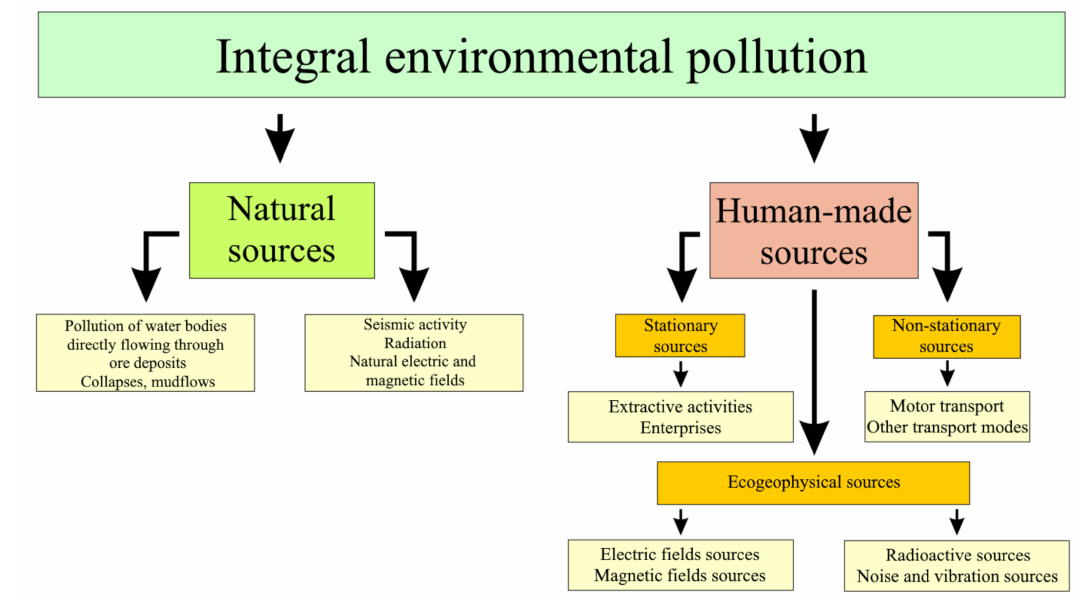
Figure 1. Scheme of the main sources of environmental pollution for the territory of the Republic of North